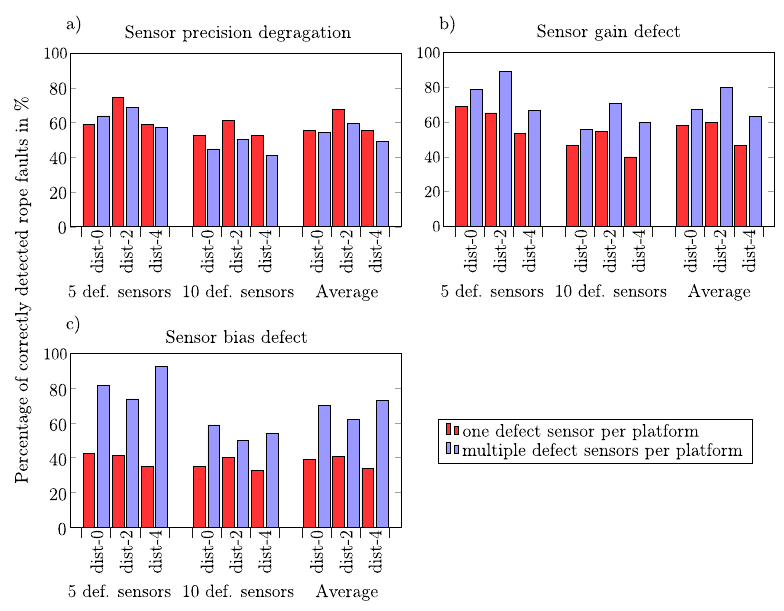
Figure 18. Comparison of single and multiple sensor defects per platform on the reliability of rope fault detection for a rope fault in rope number 1 with 4 z acceleration sensors per platform. Results for three different distances between defect sensors and the rope fault are shown: ( a ) For sensor precision degradation, ( b ) for sensor gain defects and ( c ) for sensor bias